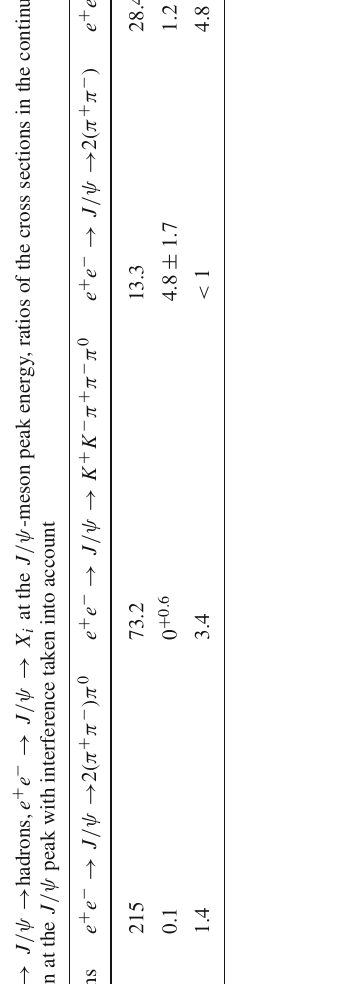
4 J /ψ decays involving intermediate resonance Considering the mass distributions of systems of final par- ticles for signal events of J /ψ → X i decays, we also esti- mated the branching fractions of some J /ψ decays involving intermediate resonances. Figures 3, 4 and 5 show such mass distributions, which were used to determine branching frac- tions of decays through a 2 , ρ , ω , K * and K 2 * mesons. The distributions were fitted using linear combinations of the MC distributions for the events of the corresponding decays and backgrounds, specified as